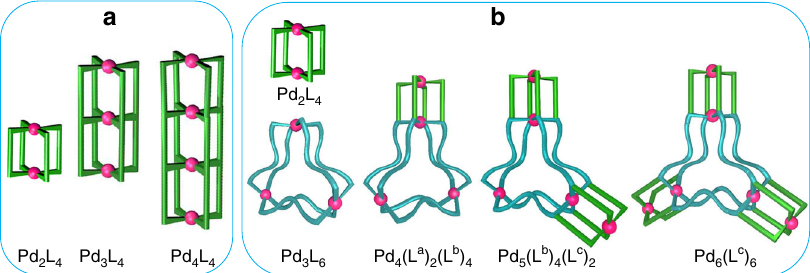
Fig. 1 Cartoon representation of the design approaches for making of self-assembled multi-3D-cavity cages. a linearly conjoined homoleptic cages 20,23 and b linearly/laterally conjoined targeted homo- and heteroleptic cages (this